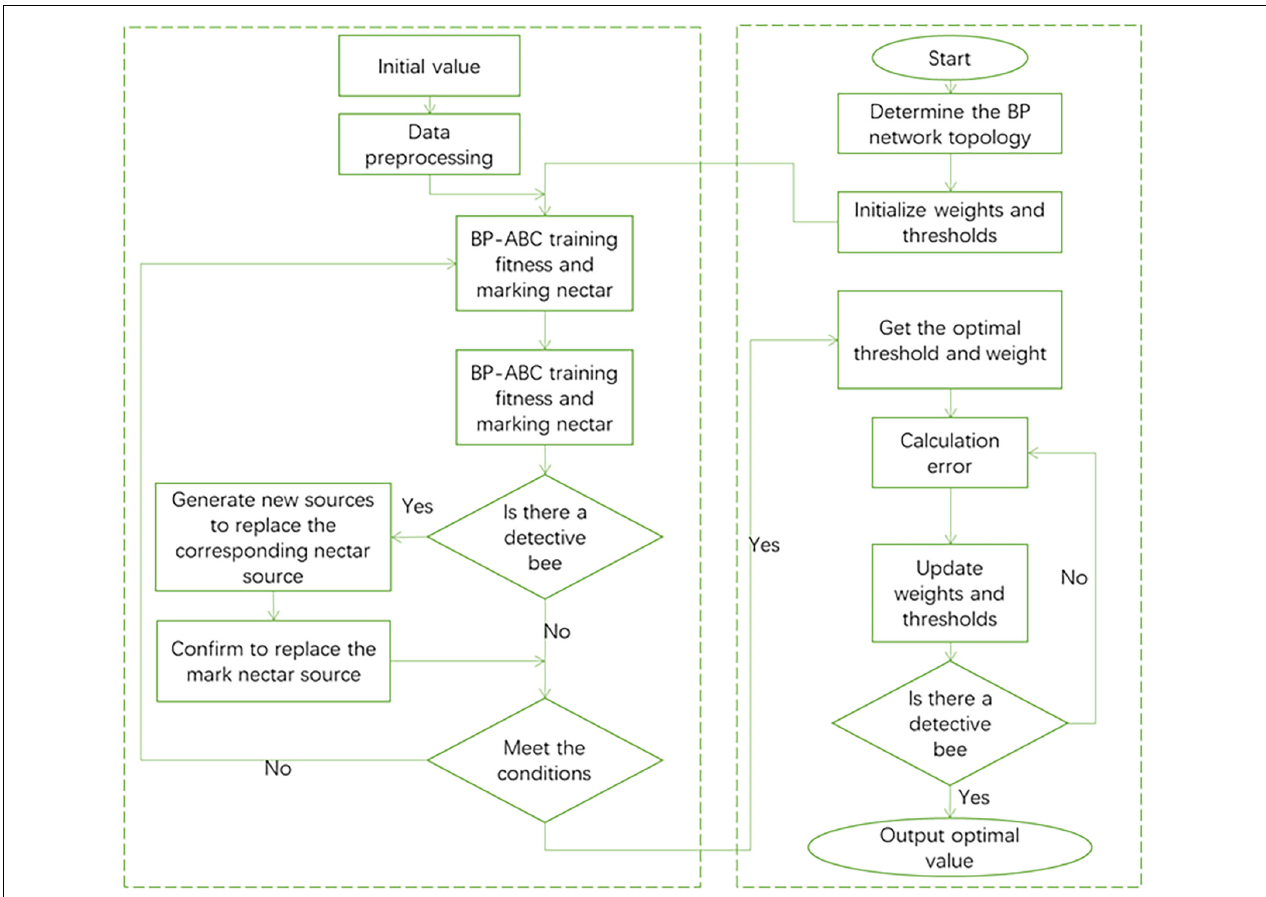
FIGURE 4 | Improved BP network flow